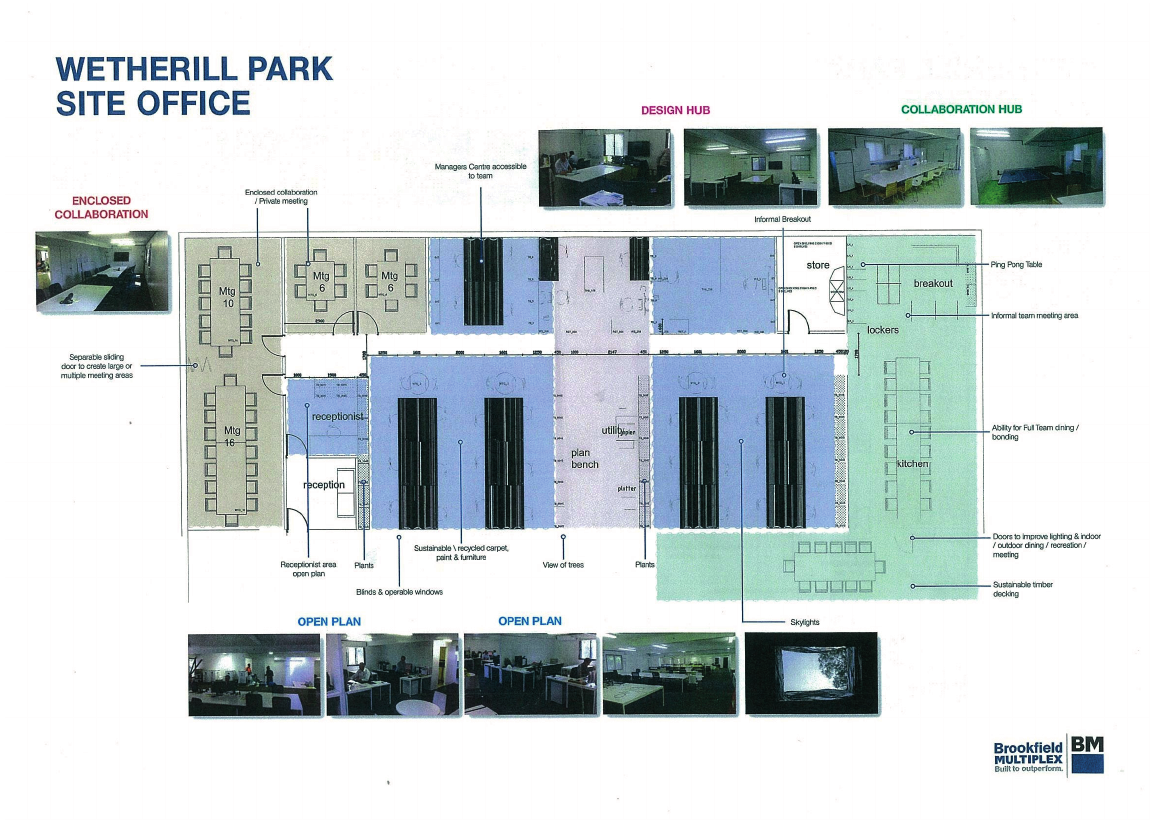
Figure A1. Bespoke site office at Brookfield Multiplex Wetherill